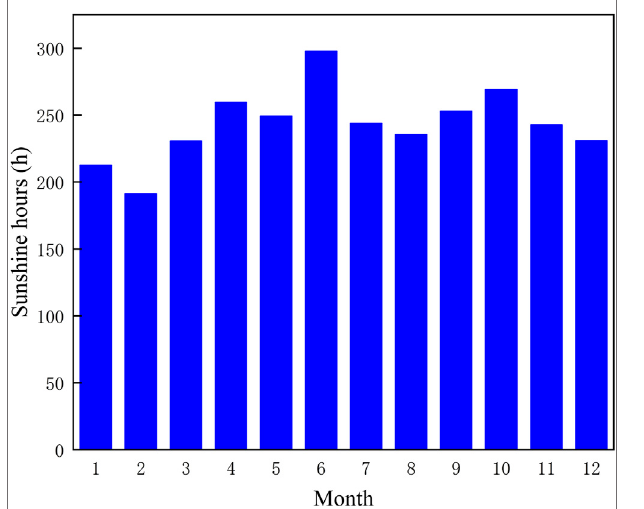
FIGURE 7 | Variation in monthly average sunshine duration in Zabuye Salt Lake from 2018 to 2020.